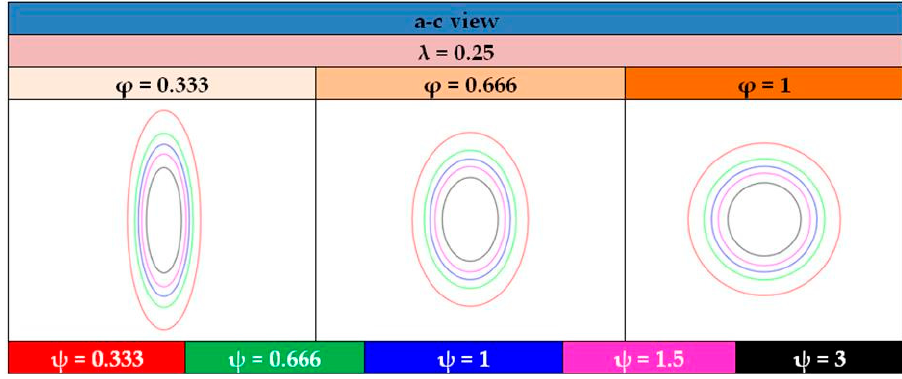
Figure 16. Graphical representation of the b–c view of tank configurations with λ = 0.25.